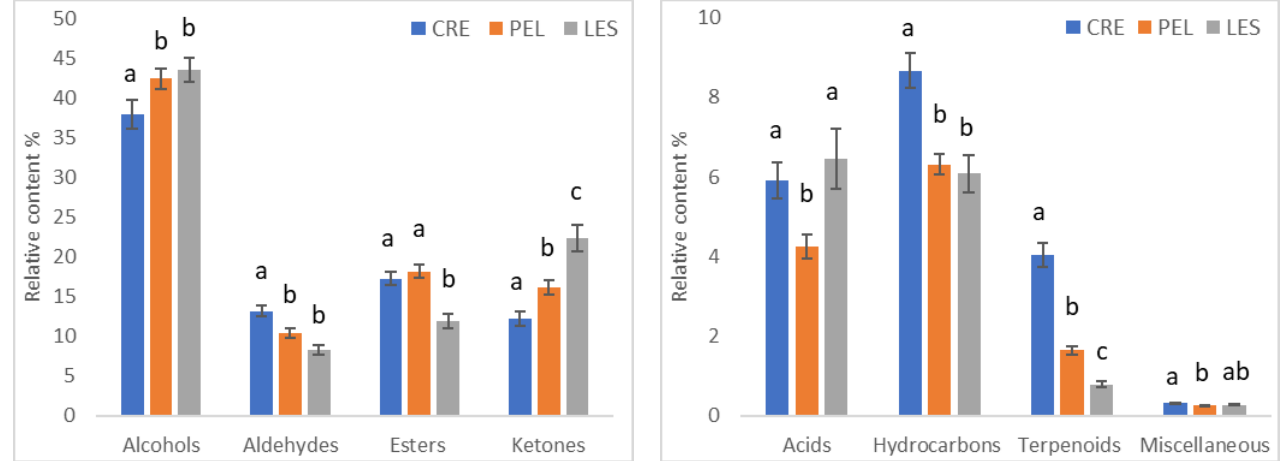
Figure 1. Comparison of the relative content (%) of the chemical classes of volatile compounds identified in EVOOs originating from various growing locations (CRE: Crete; PEL: Peloponnese; LES: Lesvos). The error bars indicate standard errors at 95% confidence level. Data in the same class with different lowercase letters differ significantly ( p < 0.05).